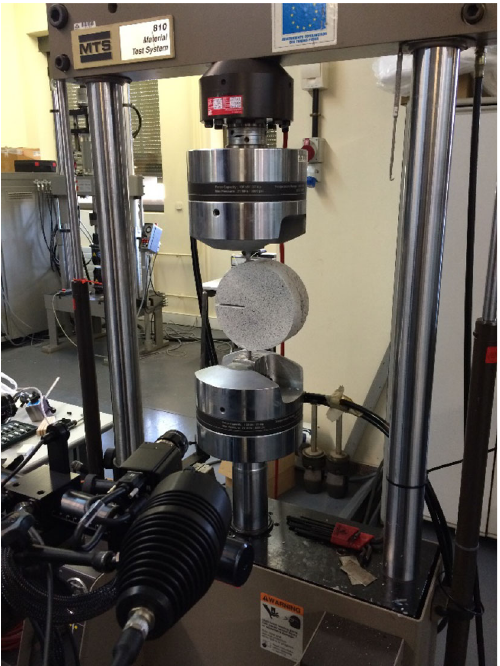
Fig. 7 MDCT test of a cylindrical sliced shape specimen with a =